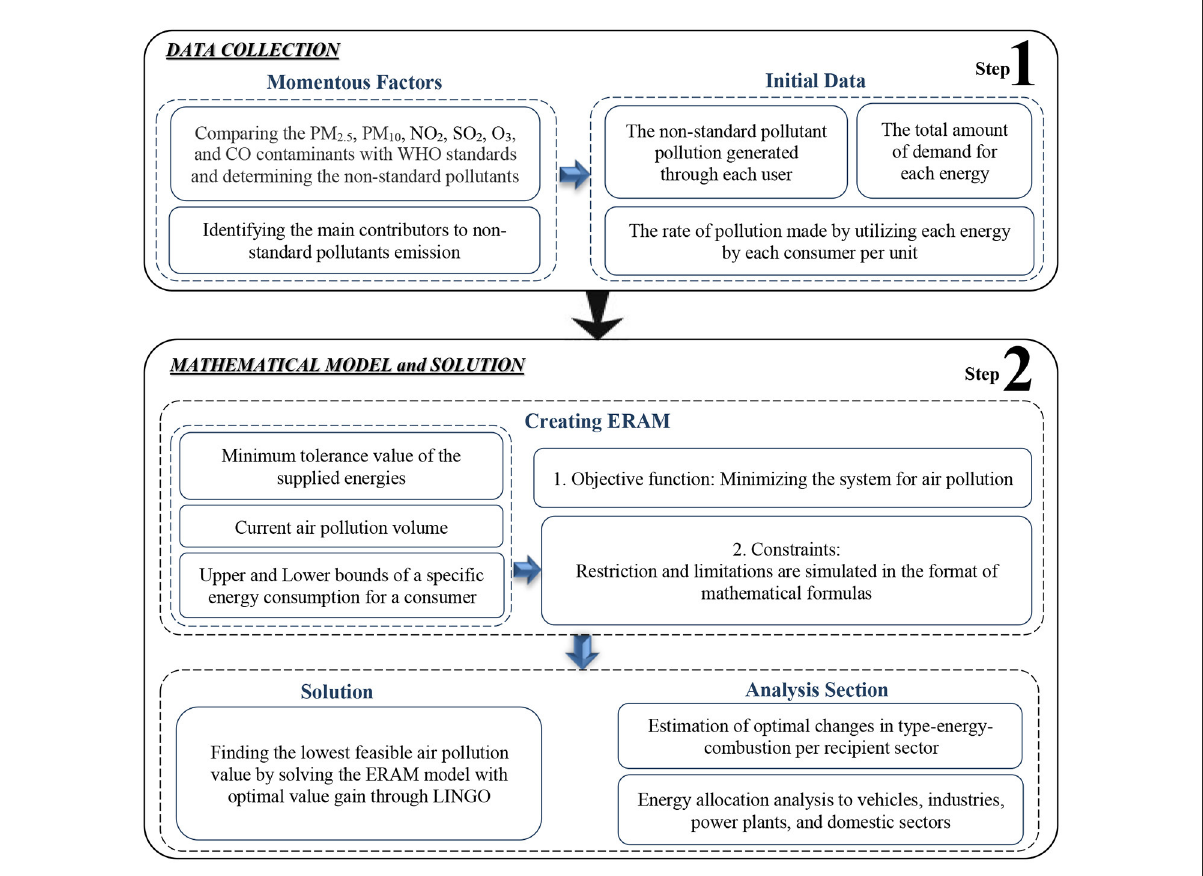
FIGURE1 The overall framework of the method for detecting optimal air quality.